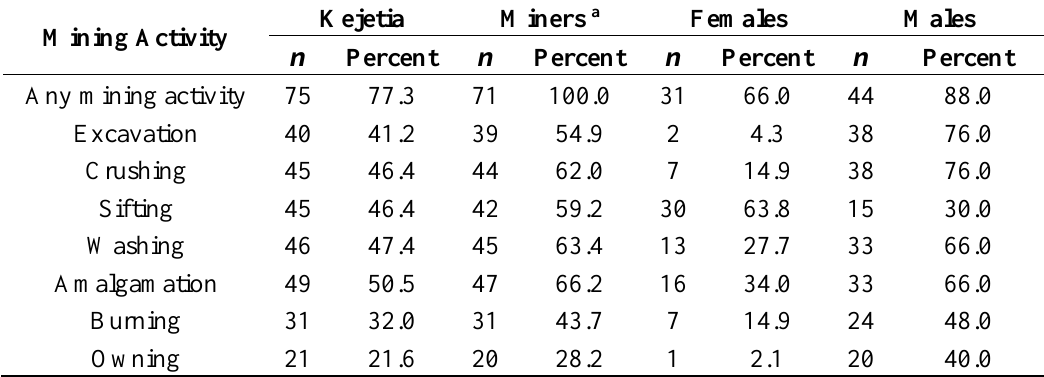
Table S1. Ever mining involvement for Kejetia participants. Participants were surveyed on ever-engaging in each mining activity.